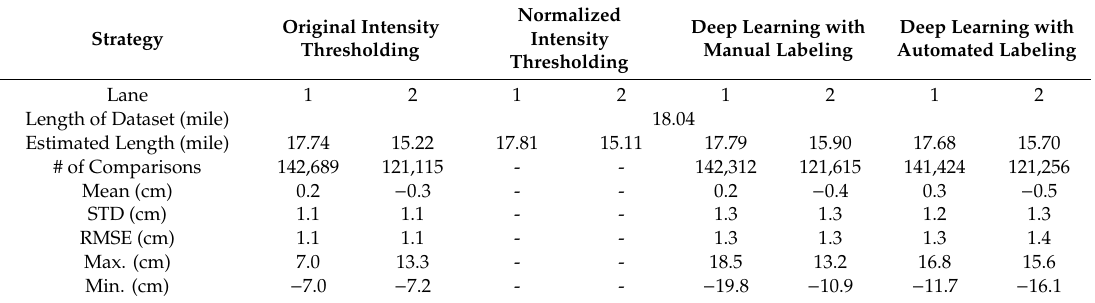
Table 8. Lane width di ff erence statistics for di ff erent lane marking extraction strategies in dataset 1. Normalized Deep Learning with Deep Learning with Original Intensity Intensity Strategy Thresholding Manual Labeling Automated Thresholding